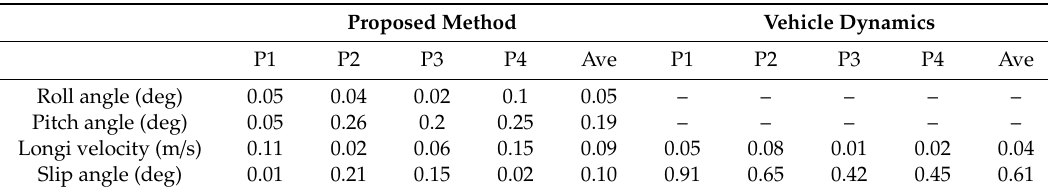
Table 1. Absolute estimation errors during critical steering in DLC maneuver. “Ave” means averaged estimation error. “P” means point.